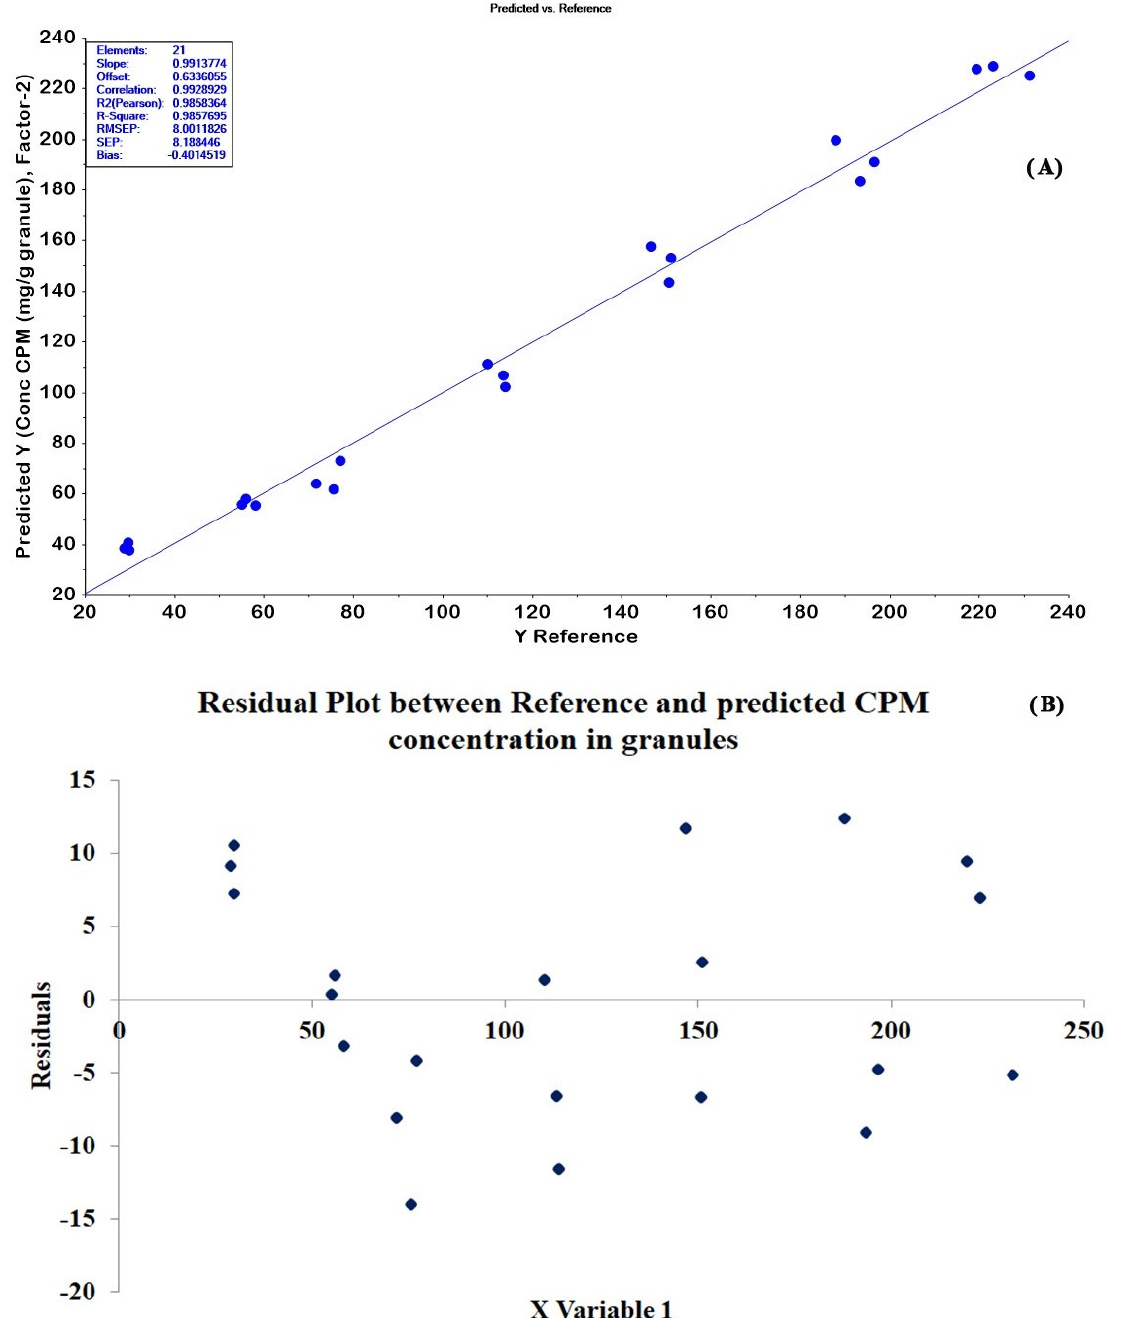
Figure 7. ( A ) The correlation plot between reference and predicted CPM contents of test set samples for granules showed the slope close to 1, a good R 2 (Pearson), low RMSEP and bias. ( B ) The residuals plots of the prediction values compared with reference values showed the random distribution of the residual values with respect to reference values.